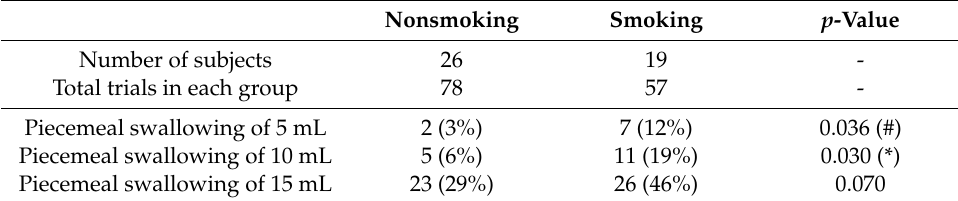
Figure 10. FSR waveform of a case of piecemeal swallowing for 20 mL of water. Table 6. Frequency of piecemeal swallowing.